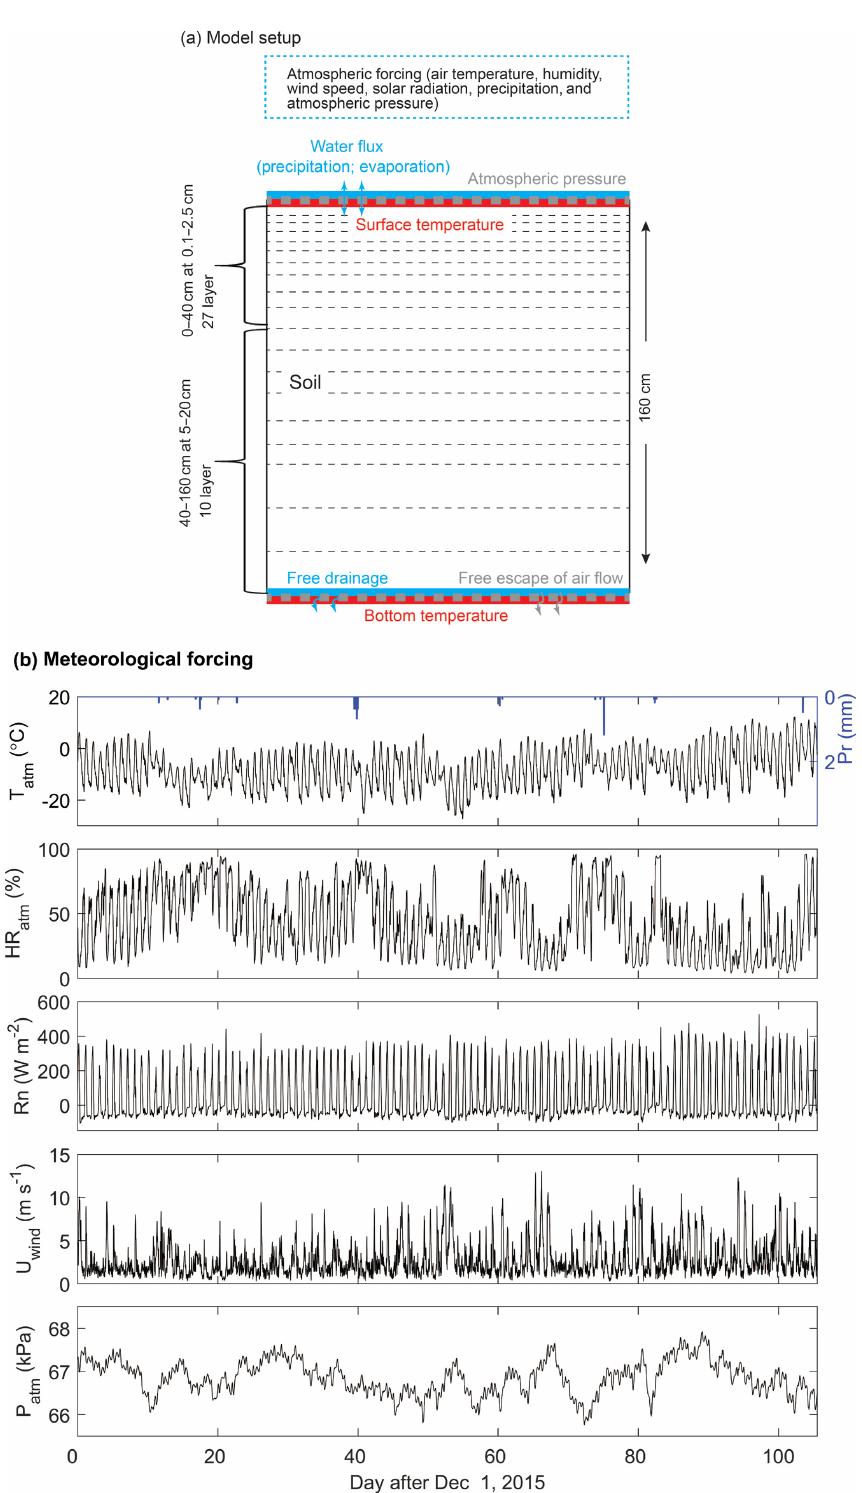
Figure 1. (a) Conceptual illustration of the model setup, the surface and bottom boundary conditions, driving forces, and vertical dis- cretization. (b) Half-hourly measurements of meteorological forcing, including air temperature ( T atm , ◦ C), relative humidity (HR atm , %), net radiation ( R n , Wm − 2 ), wind speed ( U wind , ms − 1 ), and atmospheric pressure ( P atm , kPa) during the simulation period. Note that the dimensions are not drawn to scale; models were run at a 1D